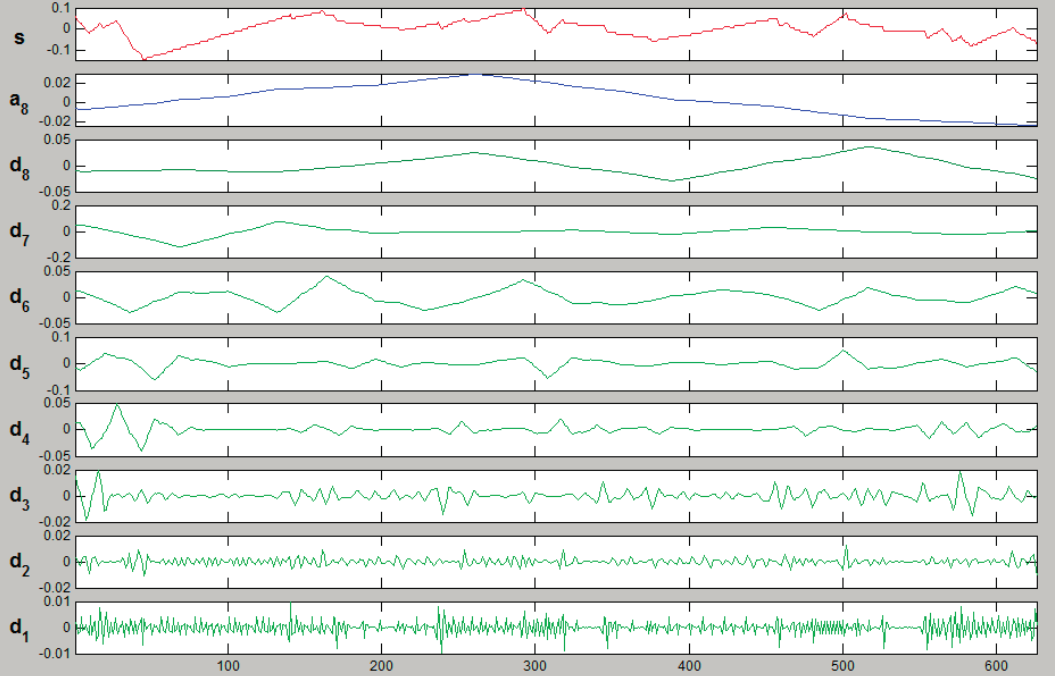
Figure 12. Signal decomposition with wavelet “sym3”, eight